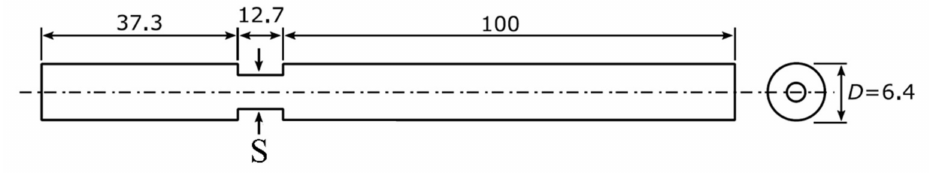
Figure 1. A sectional view of the flow domain. Flow is from left to right. The figure is out of scale, and the dimensions are in